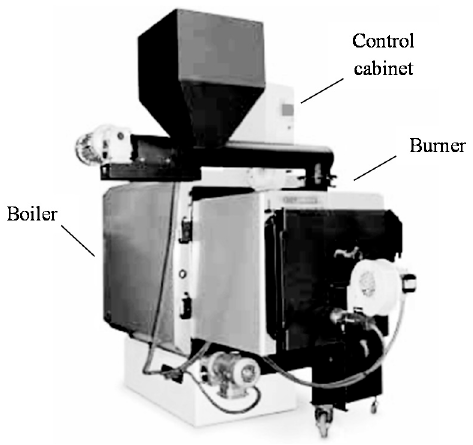
Figure 8. Flow chart of the BIO System equipment.